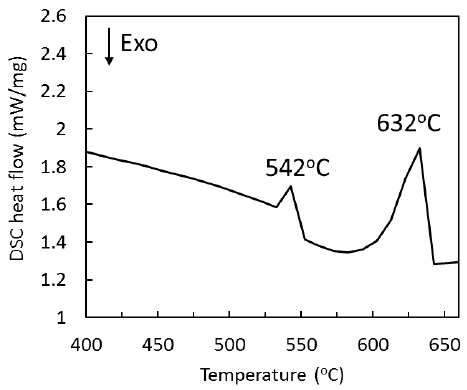
Figure 5. Differential scanning calorimetry (DSC) curve of the MgZnY-C alloy showing phase transformation upon heating. Table 2. Volume fraction of phases, grain size, Vickers hardness, and tensile properties of the tested alloys. Yield strength (YS), ultimate tensile strength (UTS), long period stacking ordered (LPSO)